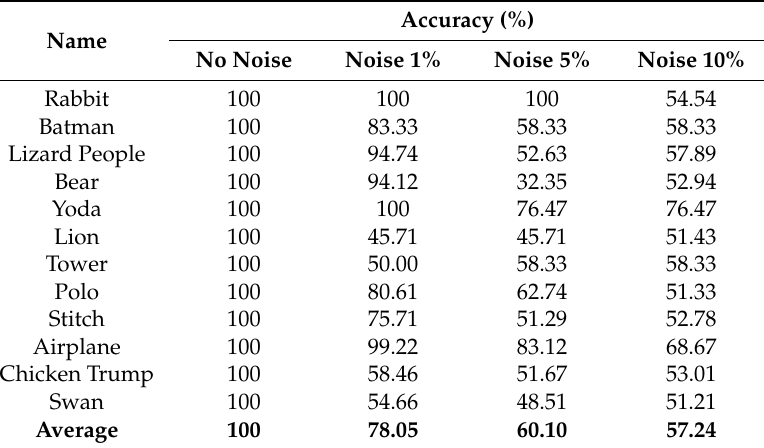
Table 2. Robustness